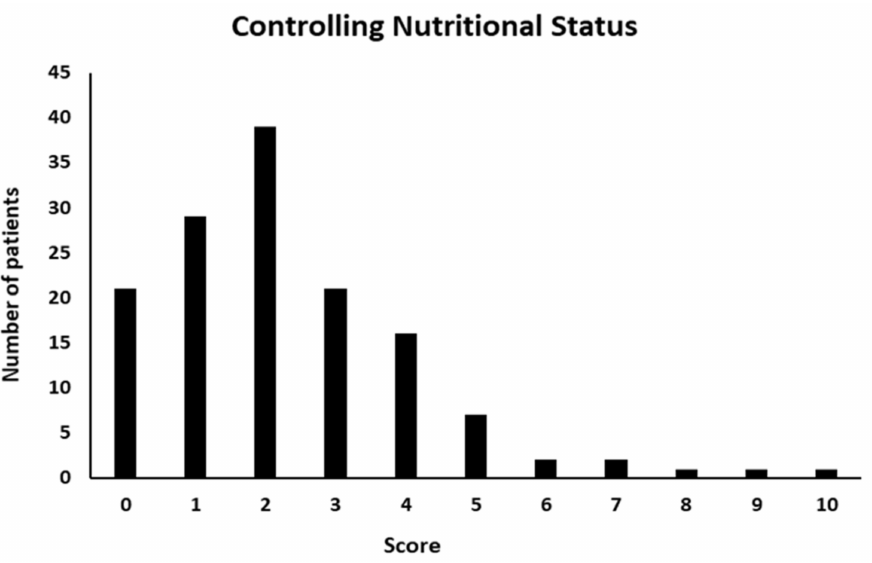
Figure 3. Controlling Nutritional Status (CONUT) score